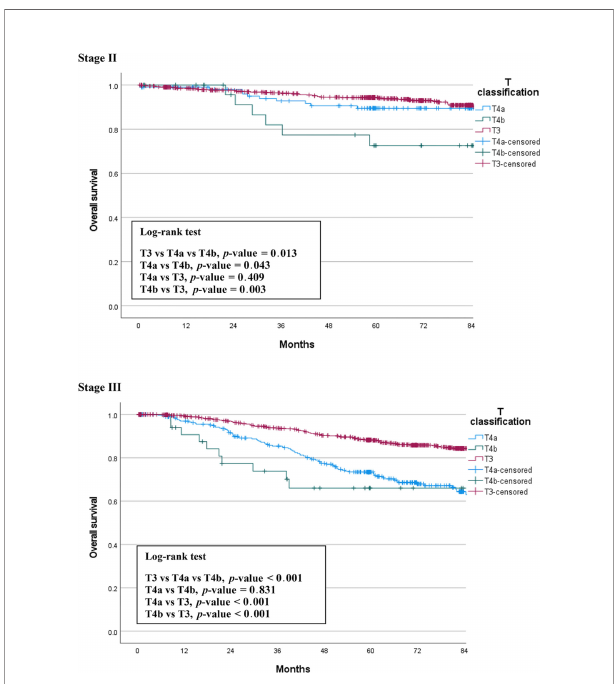
FIGURE 1 | Overall survival of T3 vs. T4 patients by